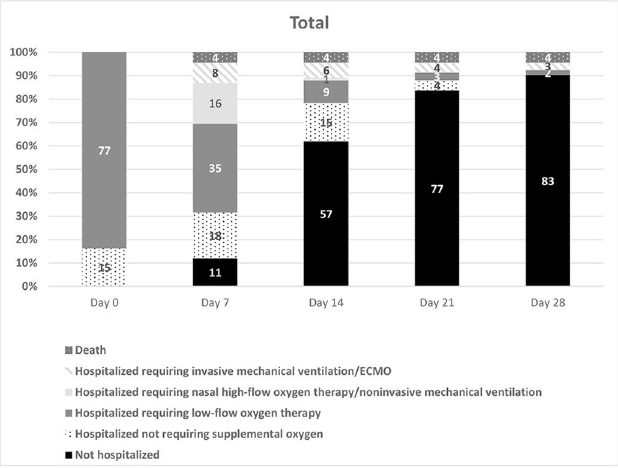
Fig 1. Clinical outcomes based on the six-category ordinal scale